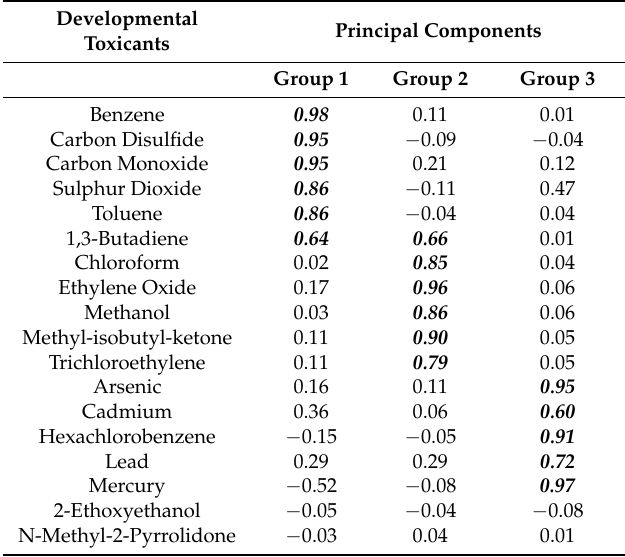
Table 3. Principal component analysis of 18 developmental toxicants.